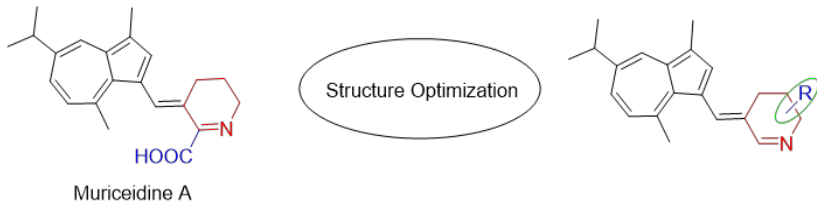
Figure 2. Chemical structure of Muriceidine A and designed compounds.